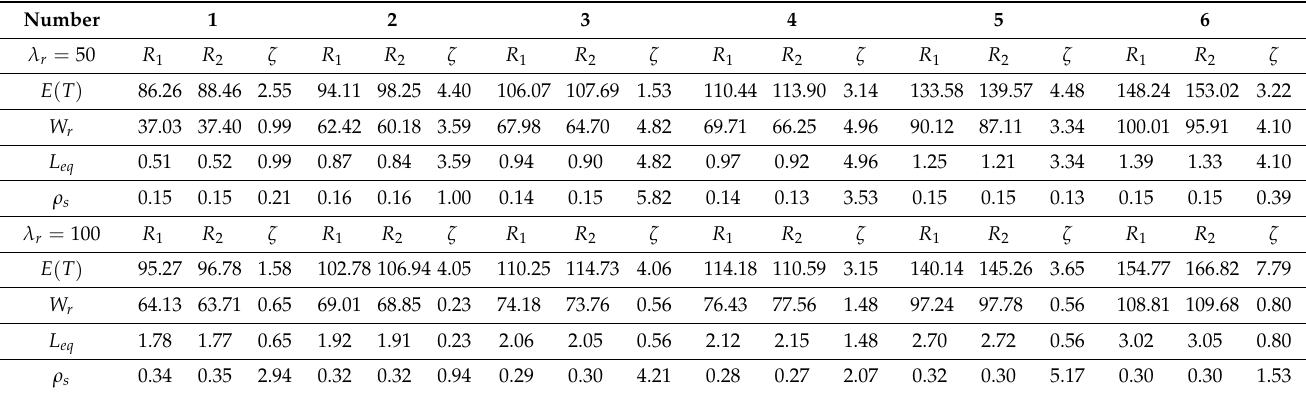
Table 6. Comparison of simulation results and theoretical